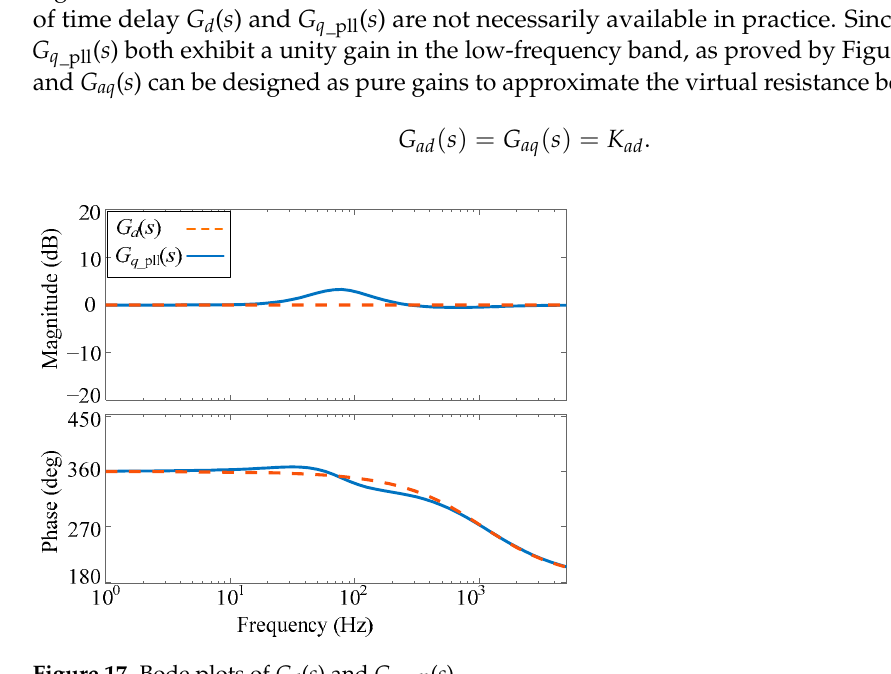
Figure 17. Bode plots of G d ( s ) and G q_ pll ( s ).